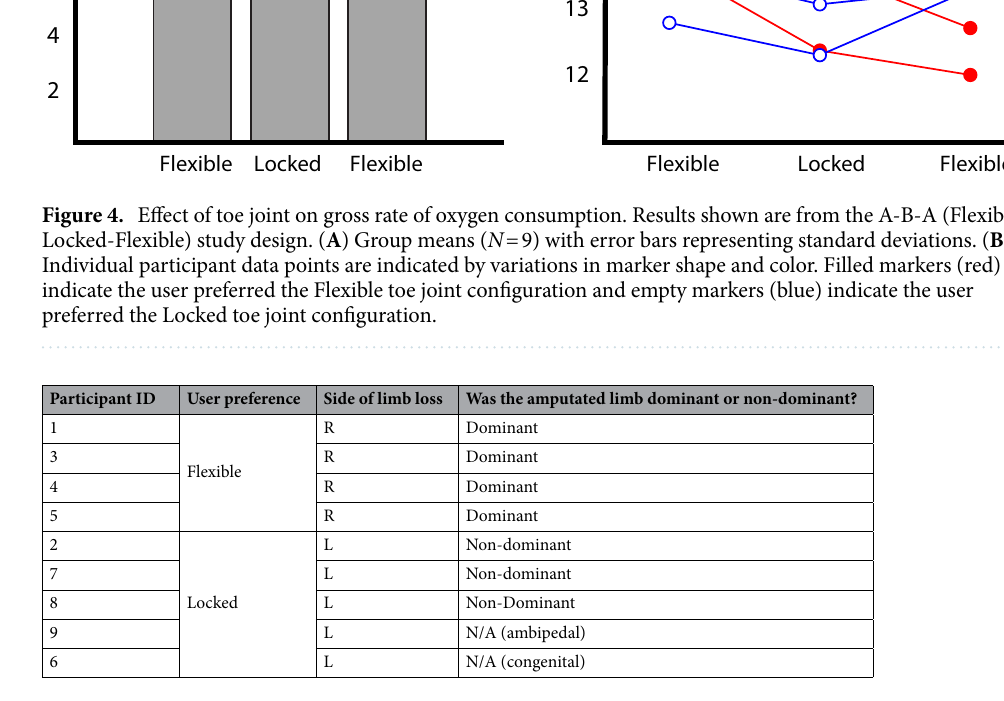
Table 3. Participant preference, side of limb loss and self-identified limb dominance before amputation (if applicable).